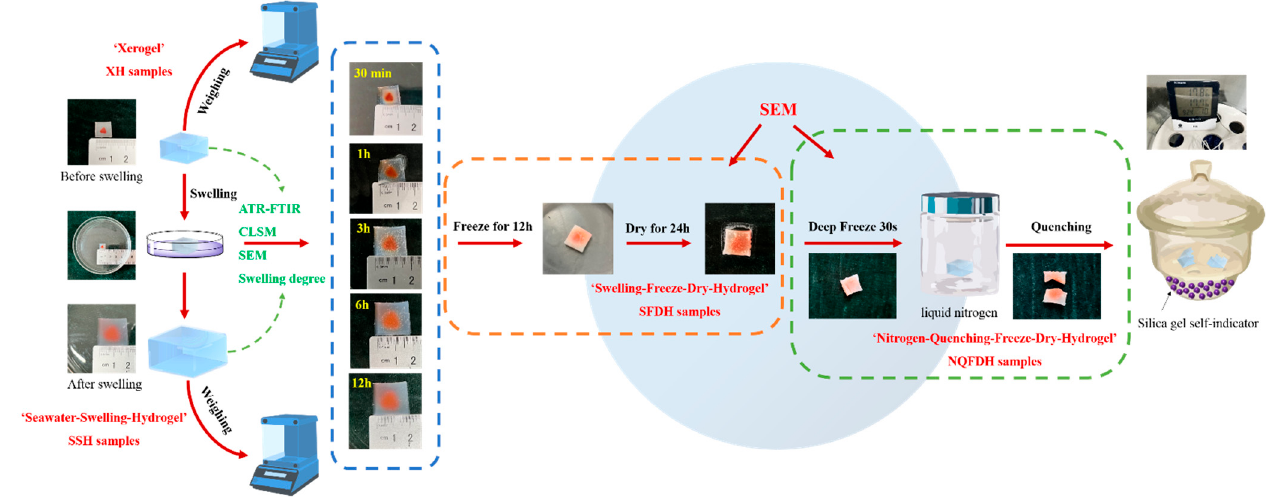
Figure 3. Swelling and freeze-drying preparation